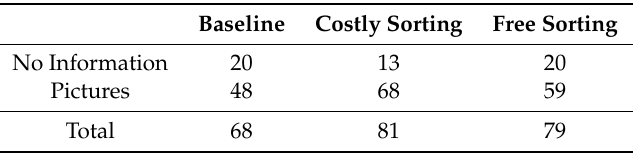
Table 2. Dictators by